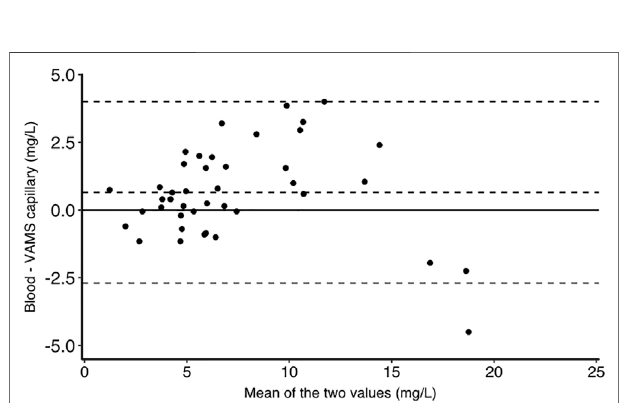
FIGURE 3 | Bland Altman graph for tranexamic acid concentration in mg/L measured in venous whole blood and VAMS capillary blood. The bias, lowerandupperlimitsofagreementareat0.7, − 2.7and4.0 mg/Lrespectively ( n (cid:1) 42).